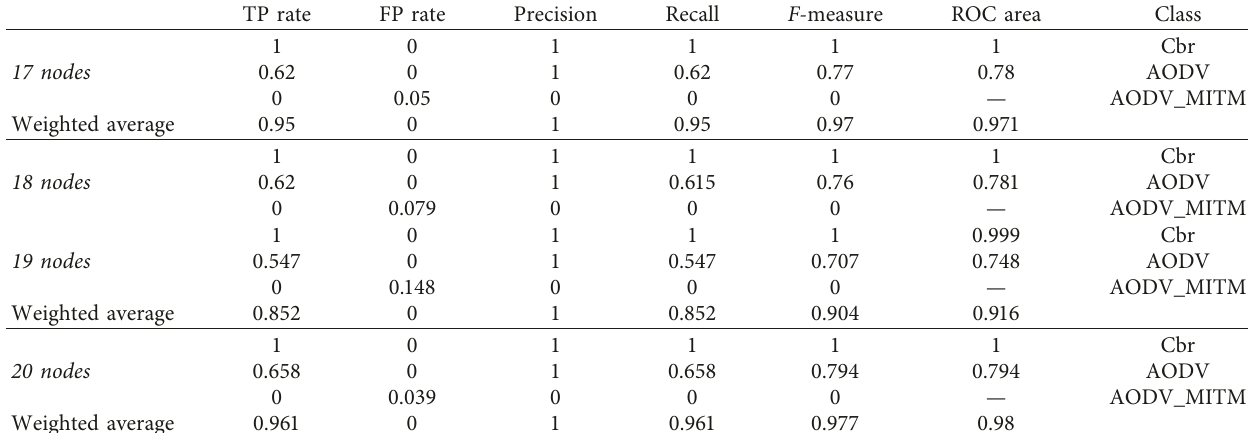
Table 3: Confusion matrices of different numbers of node configuration scenarios for stress testing with computational